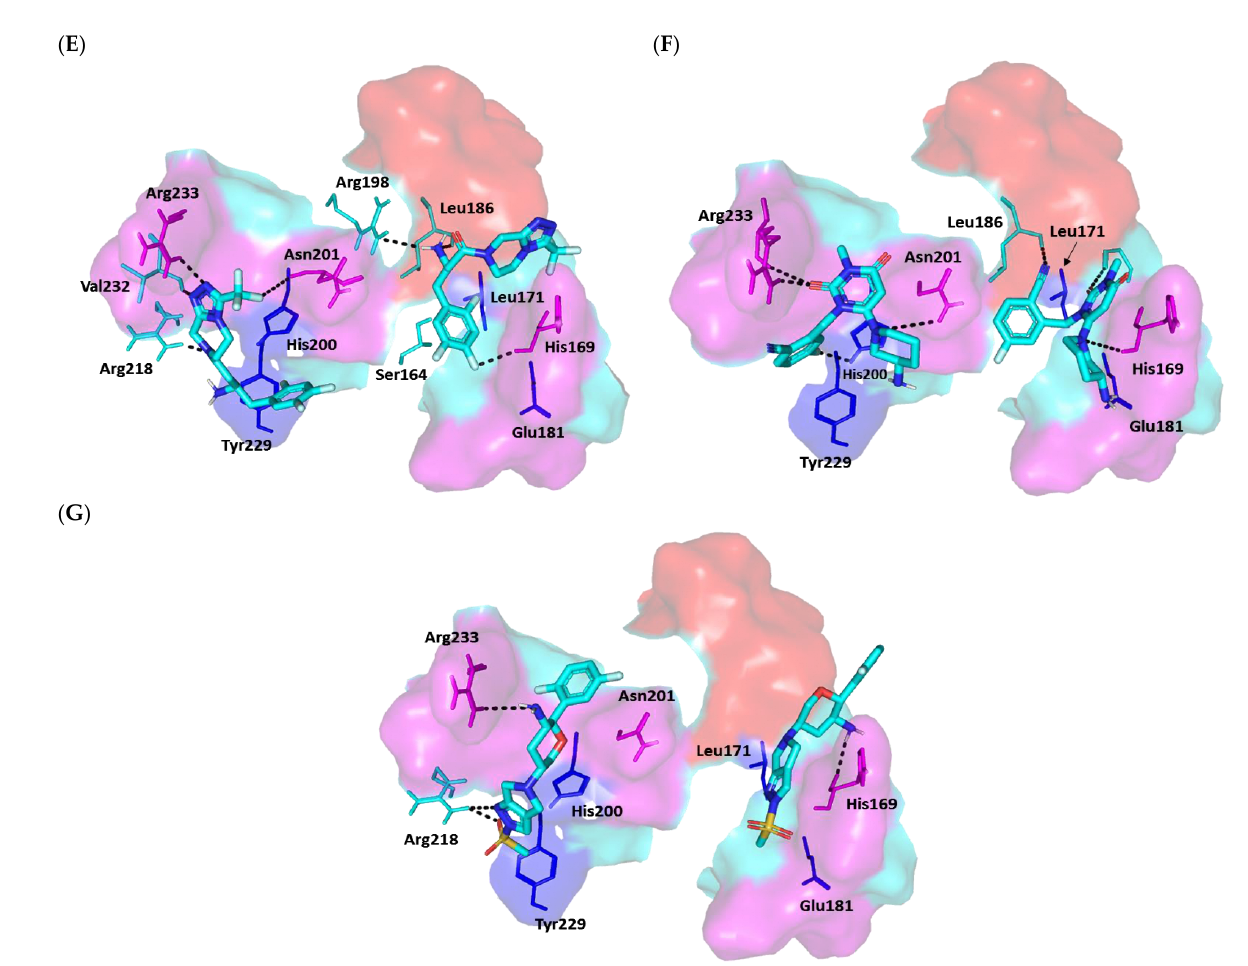
Figure 11. The architecture and predicted ligand – protein binding interactions at LytTR/DNA-binding domain of S. aureus AgrA cytoplasmic response regulator. ( A ) Overall 3D cartoon representations of S. aureus AgrA-LytTR/DNA binding sites (PDB ID: 3BS1) showing its single α -helix (red), two-fold symmetrical β -sheets (cyan), and three distinct loops (magenta) fitting in the major G1/minor G2/major G3 grooves of the co-crystallized DNA (orange). ( B ) Surface representation of the AgrA-LytTR/DNA-binding domain with key pocket residues (lines) involved within DNA binding/recognition (magenta) and/or transcriptional activation (blue). ( C ) Overlay of investigated compounds (SIT, OMR, and TRG as cyan, green, and purple lines, respectively) as well as SAV (magenta sticks) binding to the protein’s canonical binding site. ( D – G ) Predicted binding modes of the docked ligands (cyan or magenta sticks): ( D ) SAV, ( E ) SIT; ( F ) TRG, and ( G ) OMR. Residues are colored based on their respective sites and labeled with sequence numbers. Non-polar hydrogens are removed for clarity. Hydrogen bonding is depicted as black dashed lines.